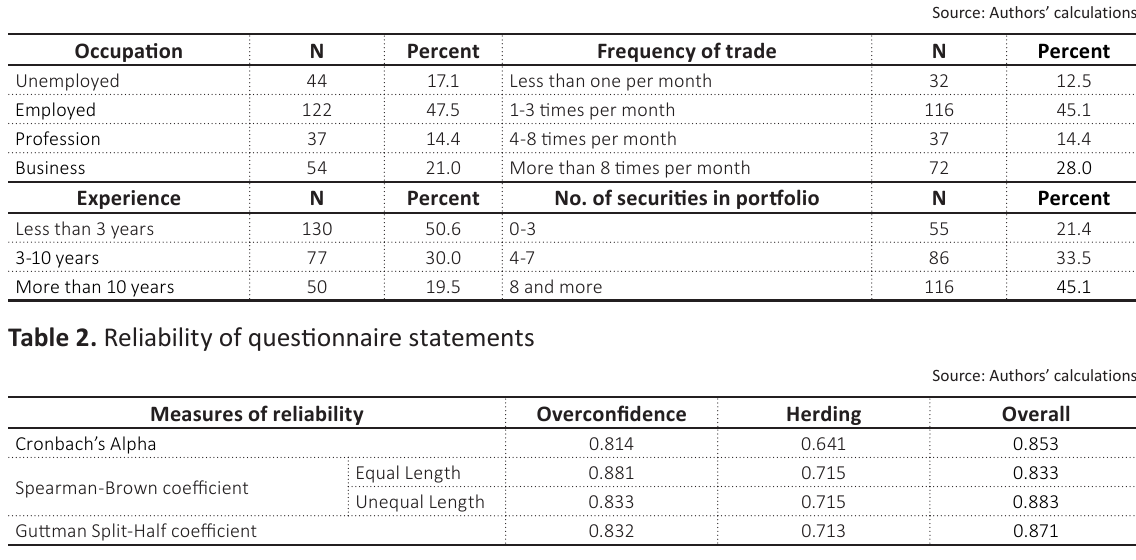
Table 1. Frequency distribution of investors in different categories